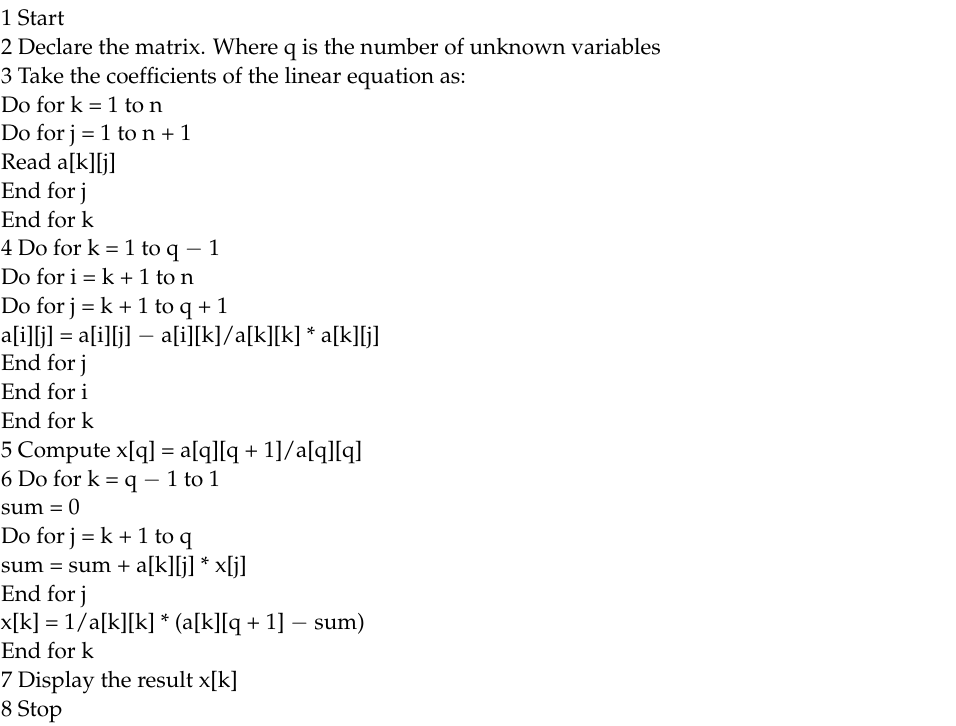
Algorithm 1. Gaussian Elimination